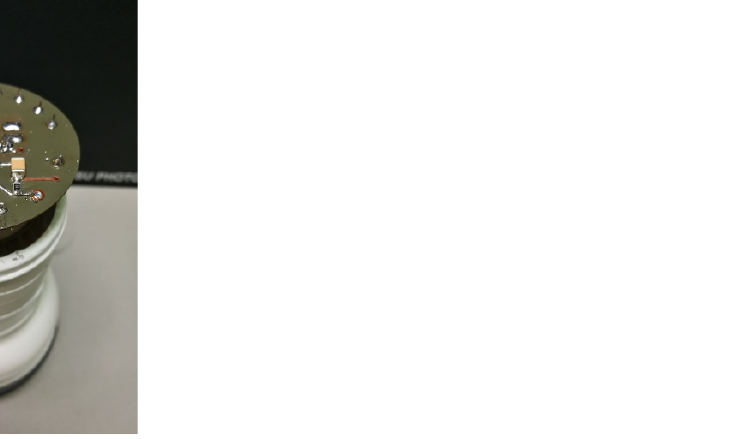
Figure 5. View of the new metal R11065-20 MOD PMT with the preamplifier–voltage divider